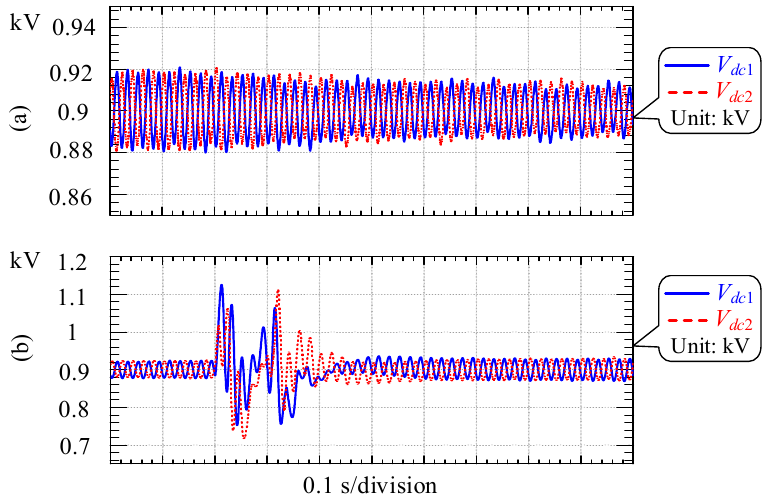
Figure 19. Upper and lower capacitor voltages ( a ) without the low voltage period and ( b ) with the low voltage period from t = 1.2 s–1.3 s.